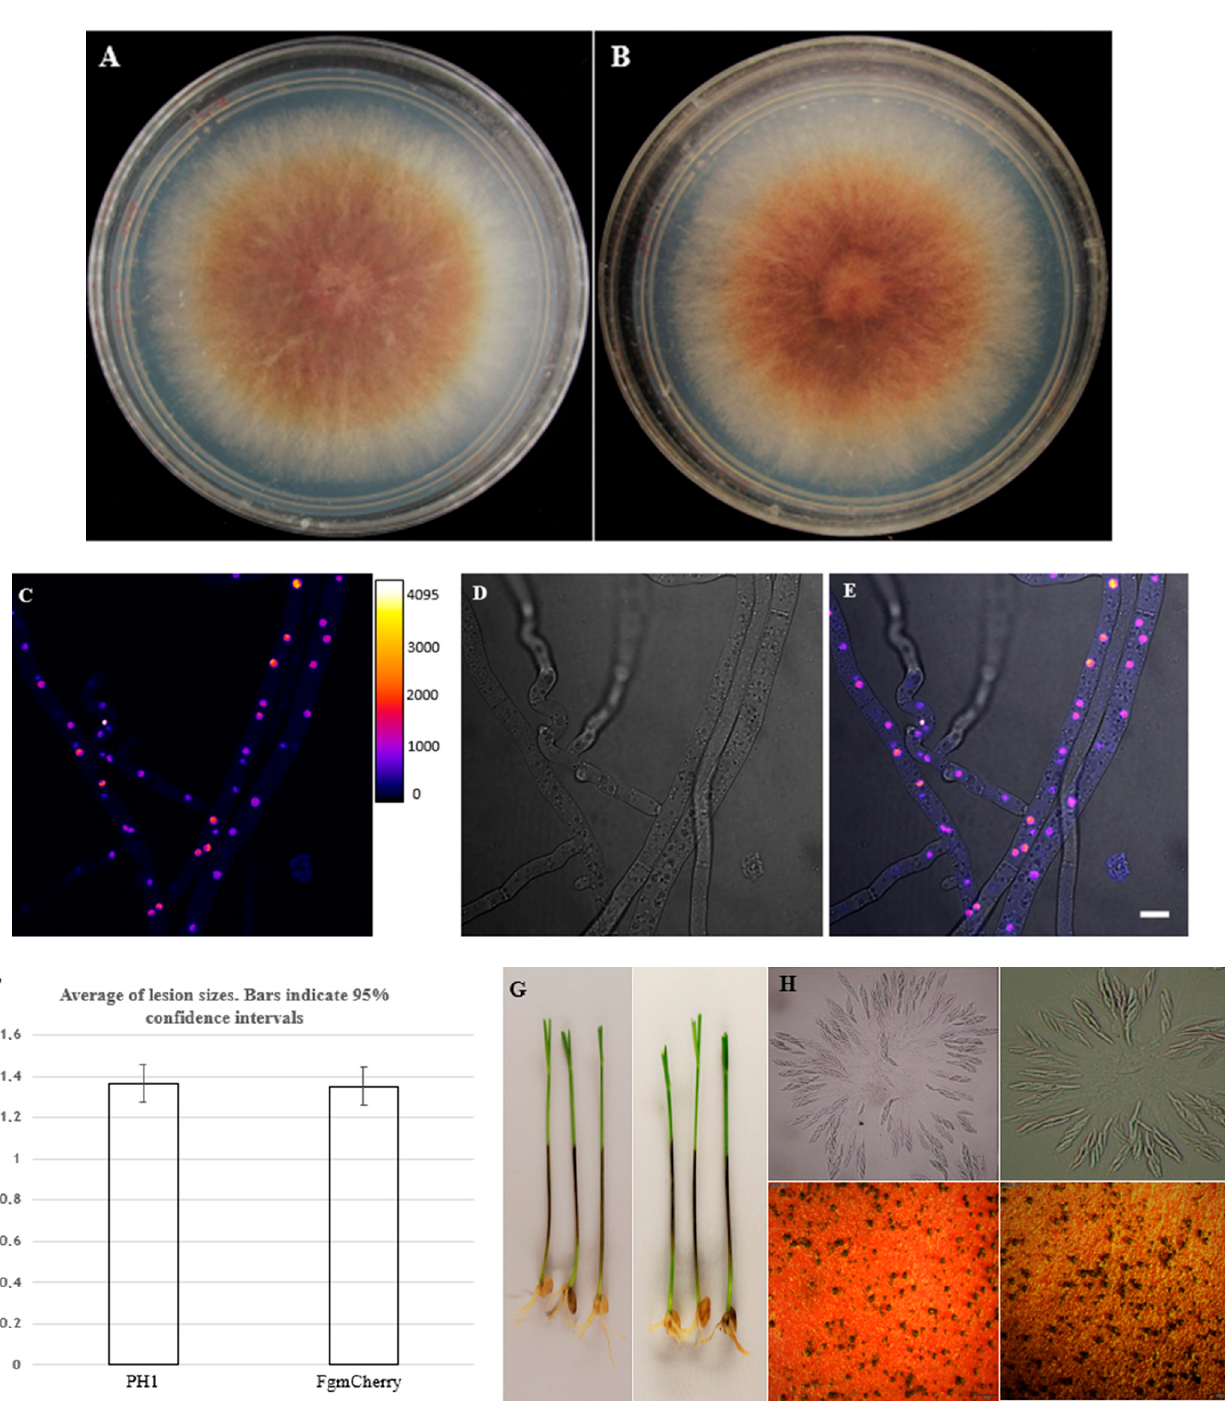
Figure 1. Validation of reporter strain FgHis1mCherry. ( A ) Wild-type PH-1 grown on DFM medium supplemented with gentamicin 0.512 mg/L to kill extracellular bacteria. ( B ) Compared with reporter strain FgHis1mCherry (FgmCherry). ( C – E ) Validation of reporter strain (FgHis1mCherry) shows the presence of the gene product of HIS1mCHERRY under a confocal microscope. The fluorescent red Fusarium graminearum is shown here using a Fire look-up table to show a large range of intensities of the confocal microscope (4096 levels) as temperature colors in the range of black, blue, red, orange, and white, which are better adapted to the human eye, revealing that His1mCherry mainly accumulates in the nuclei. ( F ) Comparison of lesion size (length) on wheat coleoptiles between PH-1 and